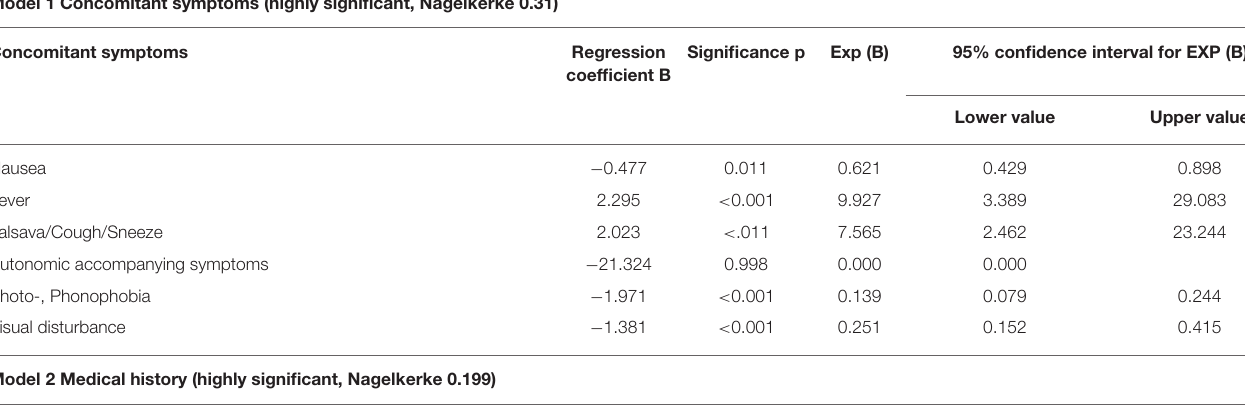
TABLE 6 | Analysis of possible risk factors for secondary headache versus primary headache. Model 1 Concomitant symptoms (highly significant, Nagelkerke